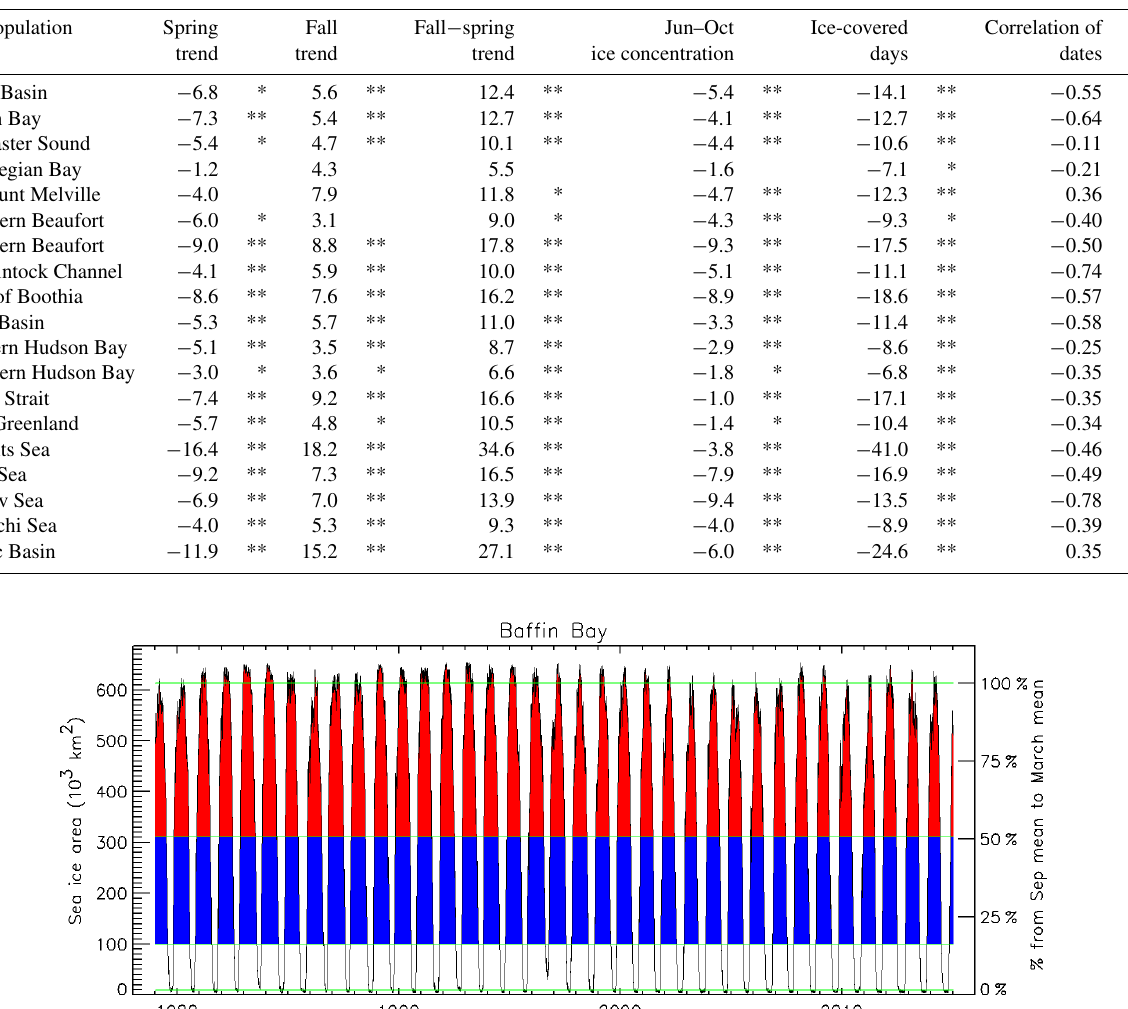
Table 3. Trend in date of spring sea-ice retreat (days decade − 1 ) , trend in date of fall sea-ice advance (days decade − 1 ) , trend in length of covered days (days decade − 1 ) , and correlation of de-trended dates of spring retreat and fall advance (dimensionless). All quantities are computed from the total marine area of each region, regardless of depth (compare Table 4), for the period 1979–2014. The trend in the length of the summer season (fall–spring trend) is equal to the fall trend minus the spring trend. Statistical significance is indicated by * (95% level) or ** (99% level) according to a two-sided F test (for trends) or a two-sided t test (for correlations).